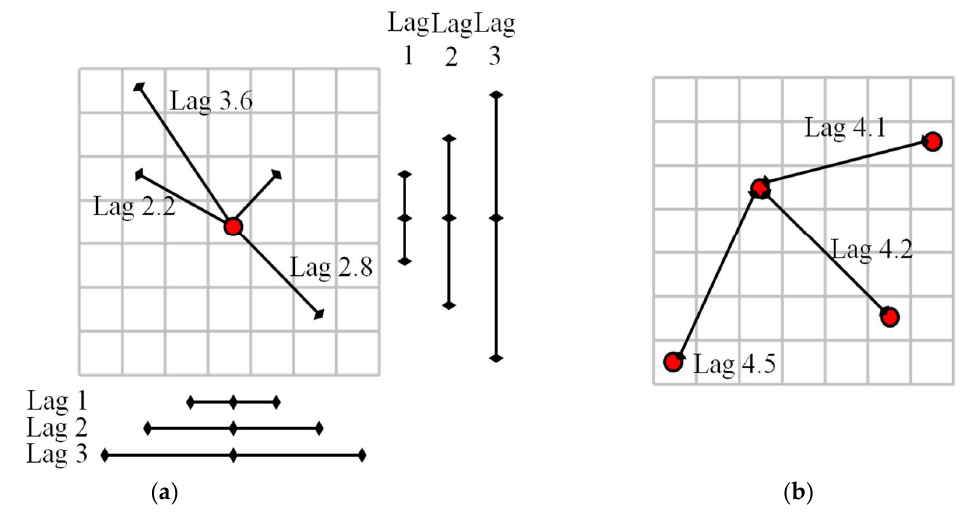
Figure 5. Difference between MCM ( a ) and CM ( b ) regarding the covariance estimation.